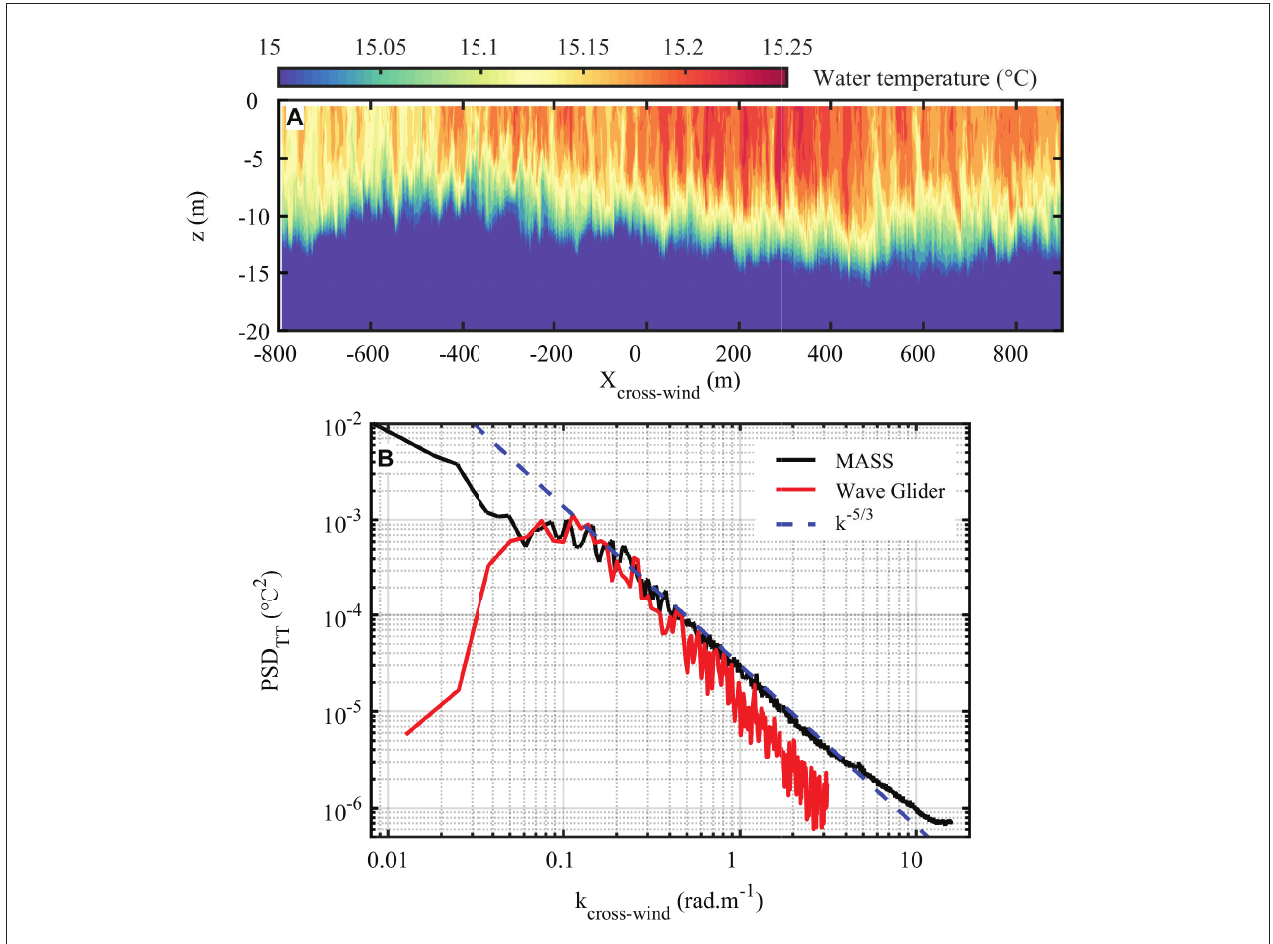
FIGURE 10 | (A) Water temperature profile map along a 1,700 m long crosswind transect highlighting the presence of shallow Langmuir cells during LCDRI2017. The transect started at 1920 UTC 30 March 2017 and was completed in only 50 min. (B) Spatial spectra of the near-surface temperature measured by the Wave Glider (red line) along with the spatial spectrum of the SST measured by the airborne MASS instrument (black line). Both spectra exhibit a peak near the wavenumber k = 0.1 rad s − 1 (i.e., wavelength λ 60 m). For the Wave Glider, the spectrum was computed on the water temperature averaged over depths in the range [0.5, 2.5] m, ∼ while for the MASS, the spectrum was computed on the sea surface temperature measured by the infrared